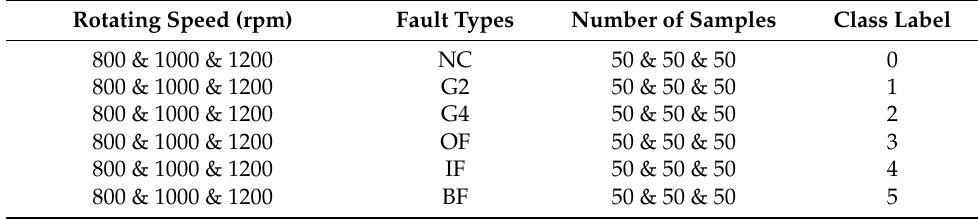
Table 1. Description of the gearbox dataset.